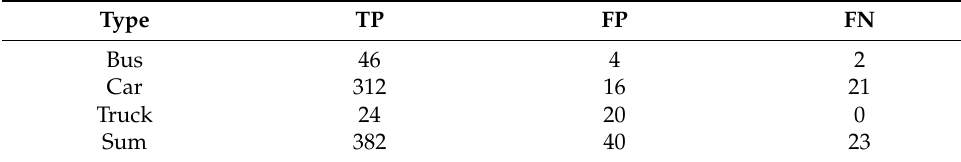
Table 8. RetinaNet model detection results.